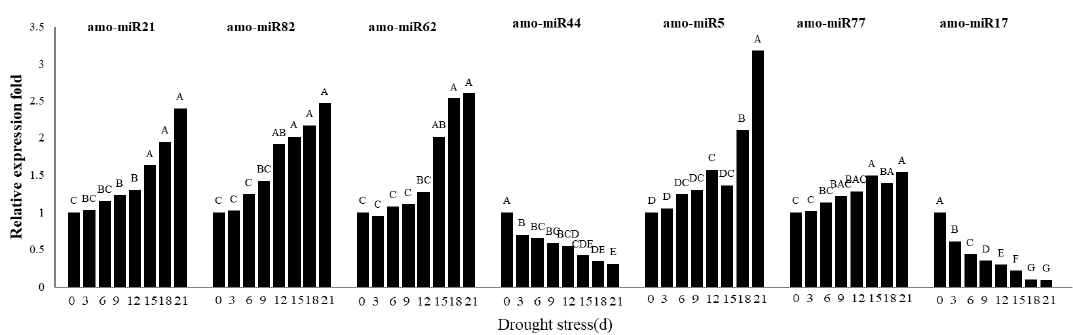
Figure 7. Expression profile of miRNAs in A. mongolicum under drought stress. Note: When the seedlings of A. mongolicum reached 15 cm high, the plants were divided into two groups randomly, the control group and the drought stressed group. The Sample of drought stressed group were collected at 0, 3, 6, 9, 12, 15,18 and 21 d post drought treatment, and untreated plants were included as the control. The expression levels of seven amo-miRNAs were examined via qRT-PCR. Expression levels were estimated using the 2 -ΔΔCT method, and U6 was used as a reference gene. Different letters on the column mean significant difference among different treatments at 0.01 level.